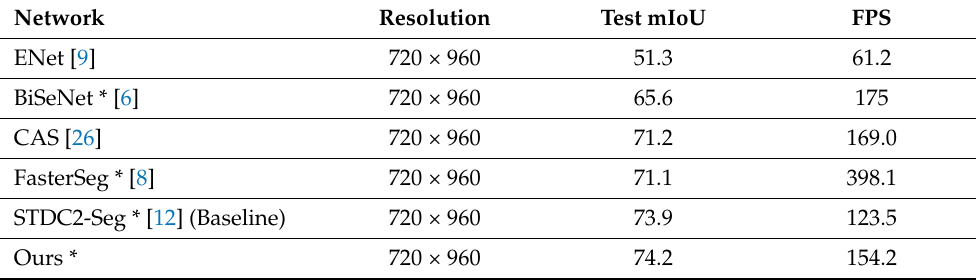
Table 5. Accuracy and speed results of different networks on Camvid dataset. * means using